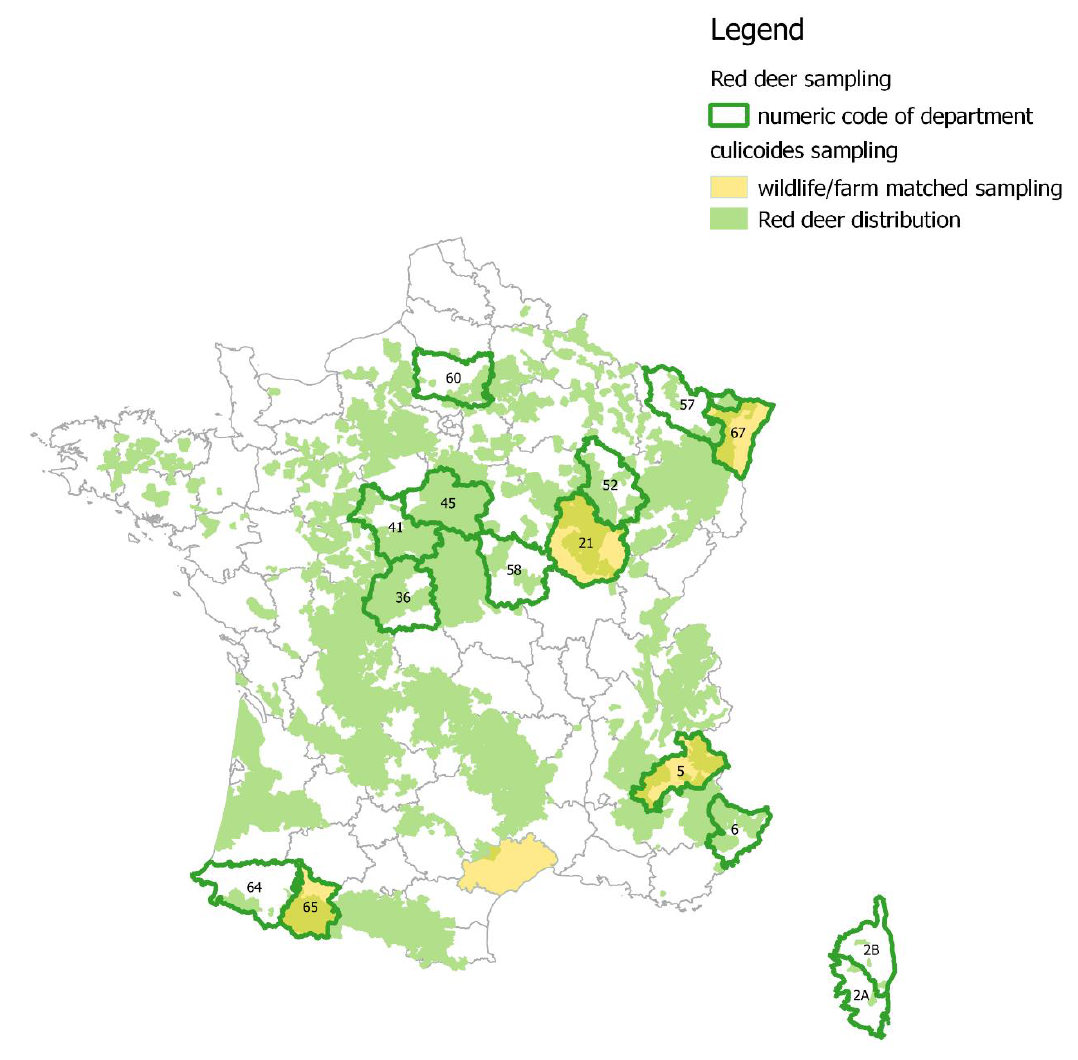
Figure 2. Localization of red deer and Culicoides samples.